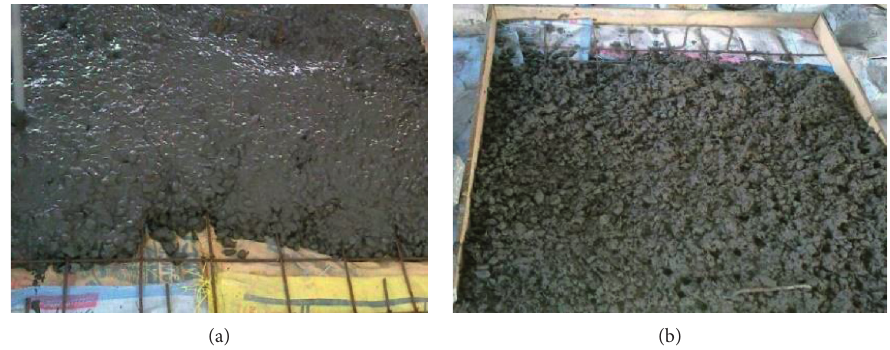
Figure 3: A view of making of waste paper concrete slab. (a) Conventional mix. (b) Glass-fiber reinforced mix.